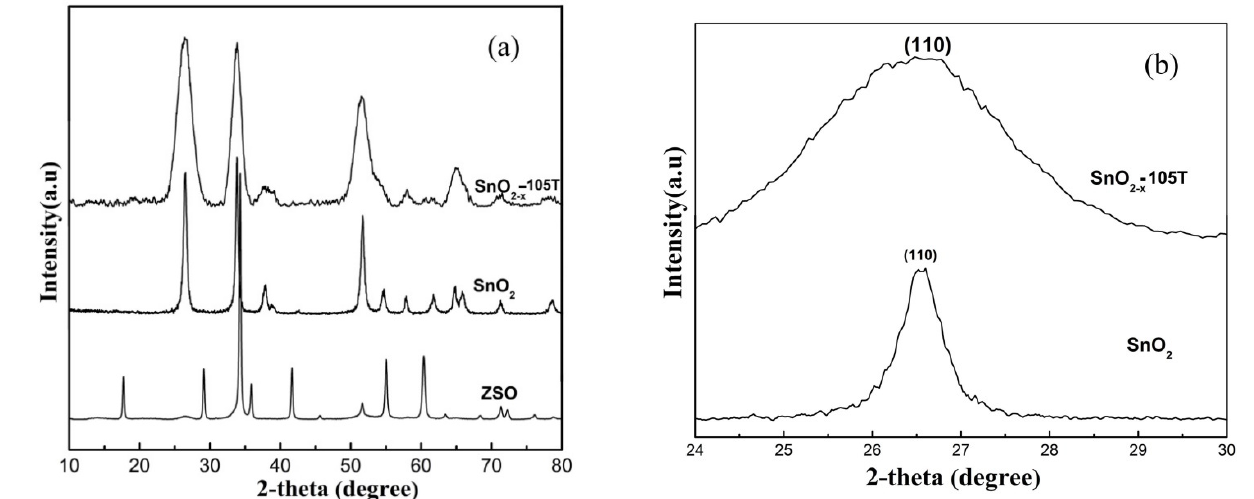
Figure 2. ( a ) XRD patterns of the ZSO, SnO 2 , and SnO 2 − x -105T samples; ( b ) partially enlarged diffraction peak of (110) plane of the SnO 2 and SnO 2 − x -105T samples.